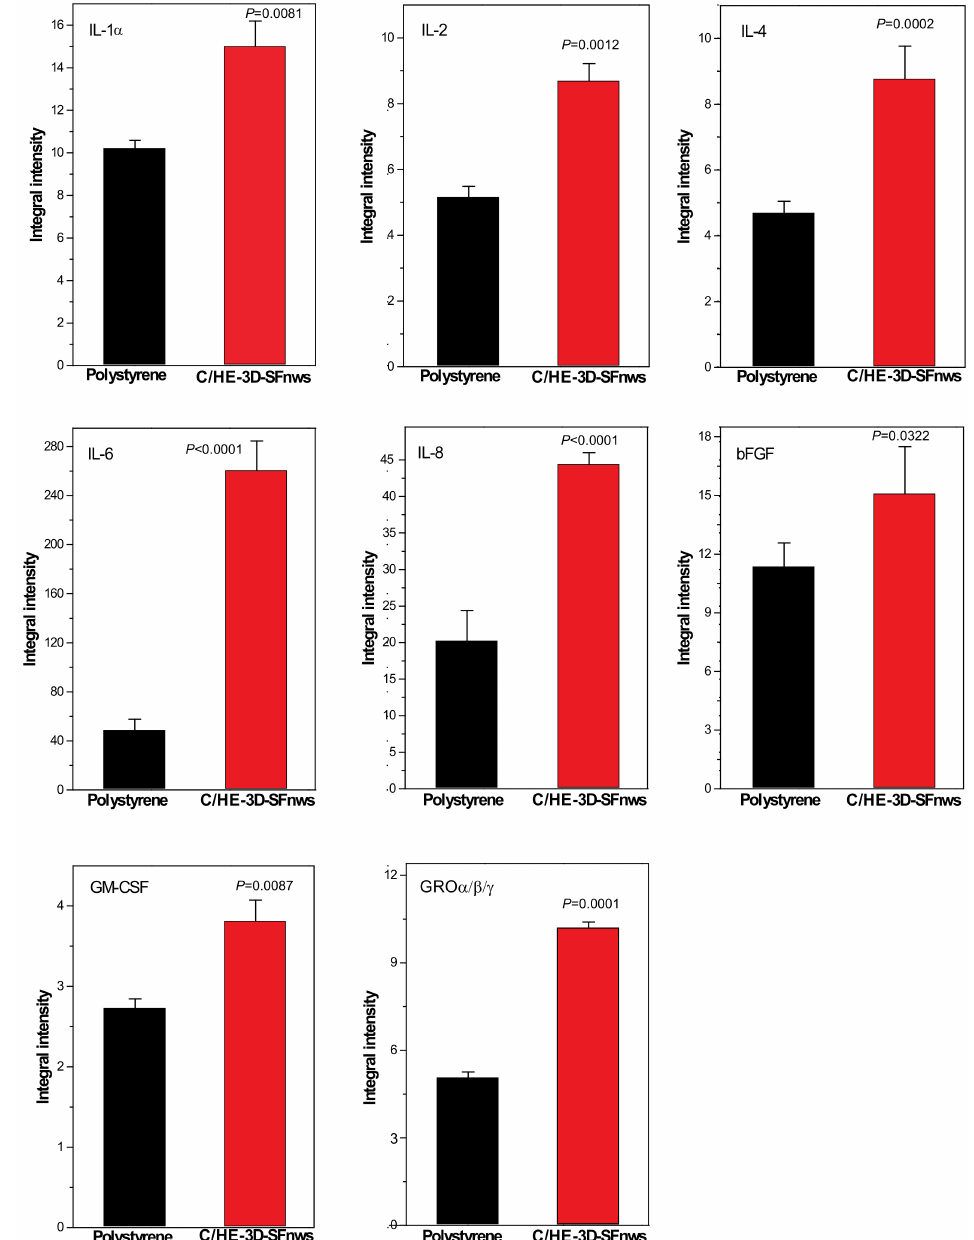
Figure 3. The angiogenic and trophic factors (AGFs) carried by the exosomes released from AHSMCs grown on C/HE-3D-SFnws vs. polystyrene. Equal amounts of exosomal proteins isolated from AHSMCs-conditioned pooled media samples of the two experimental groups were subjected to membrane-based double-antibody arrays, detecting the relative levels of multiple AGFs. The adhe- sion to C/HE-3D-SFnws significantly affected the levels of the eight exosomally carried AGFs shown in Figure. The bars are integral intensity values expressed as mean values ± standard deviations (SDs) from three distinct experiments, each conducted in duplicate. The corresponding p values of the differences between each couple of bars are also shown over the top of the right bars. For technical details, consult the Section